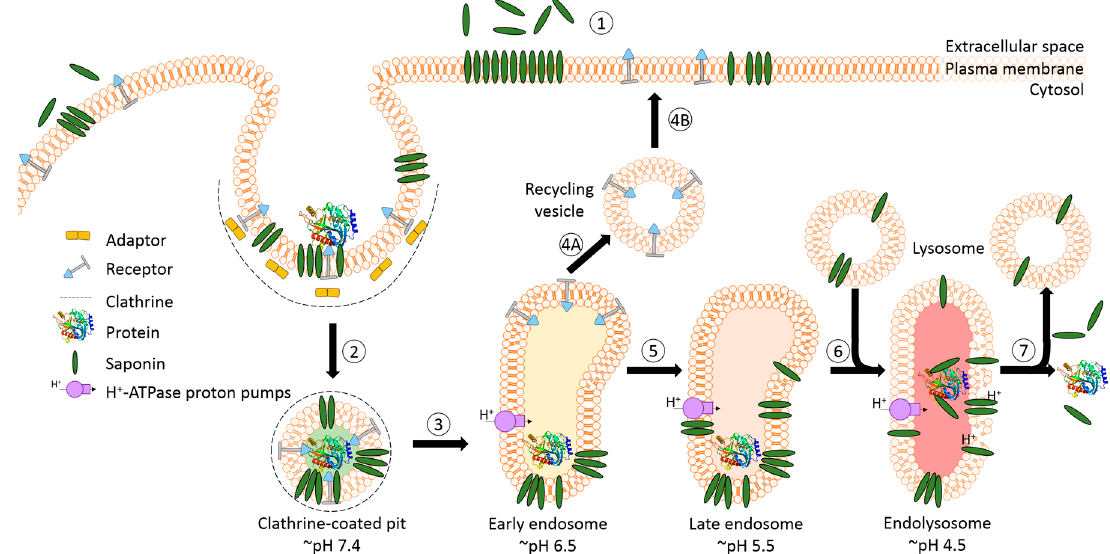
Figure 5. Model of the receptor-mediated endocytic uptake of a tumor-targeted protein in the presence of saponins with endosomal escape enhancer features. ( 1 ) The first step is the application of saponins prior to the targeted protein. The saponins integrate, due to their amphiphilic character, into the plasma membrane but do not affect the integrity, presumably because this particular group of saponins require an acidic pH; ( 2 ) The targeted protein binds to the cognate receptor and is internalized via the clathrin-dependent pathway. Saponins are taken up simultaneously together with the targeted protein and remain in the budded vesicle; ( 3 ) The clathrin is removed and the uncoated vesicle fuses with the early endosome; ( 4A – B ). After acidic release of the protein, the receptor and a large part of the membrane might recycle back to the surface; ( 5 ) The targeted protein and membrane-associated saponins are transported via carrier vesicles to late endosomes; ( 6 ) The late endosomes fuse with lysosomes to endolysosomes. During the entire transport process, the pH continuously drops. The acidic pH in late endosomes and endolysosomes might initiate the association of saponins with the protein; ( 7 ) The saponins then mediate the endosomal release of the protein through the membrane into the cytoplasm. The molecular mechanism is not clear to date and appears to be a sophisticated interaction of cholesterol and other components of the membrane with the saponins and the protein triggered by low pH.